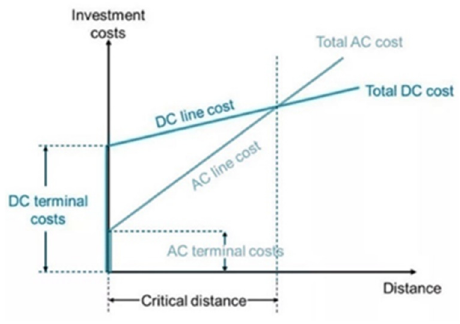
Figure 2. HVDC technology—Economical advantage.